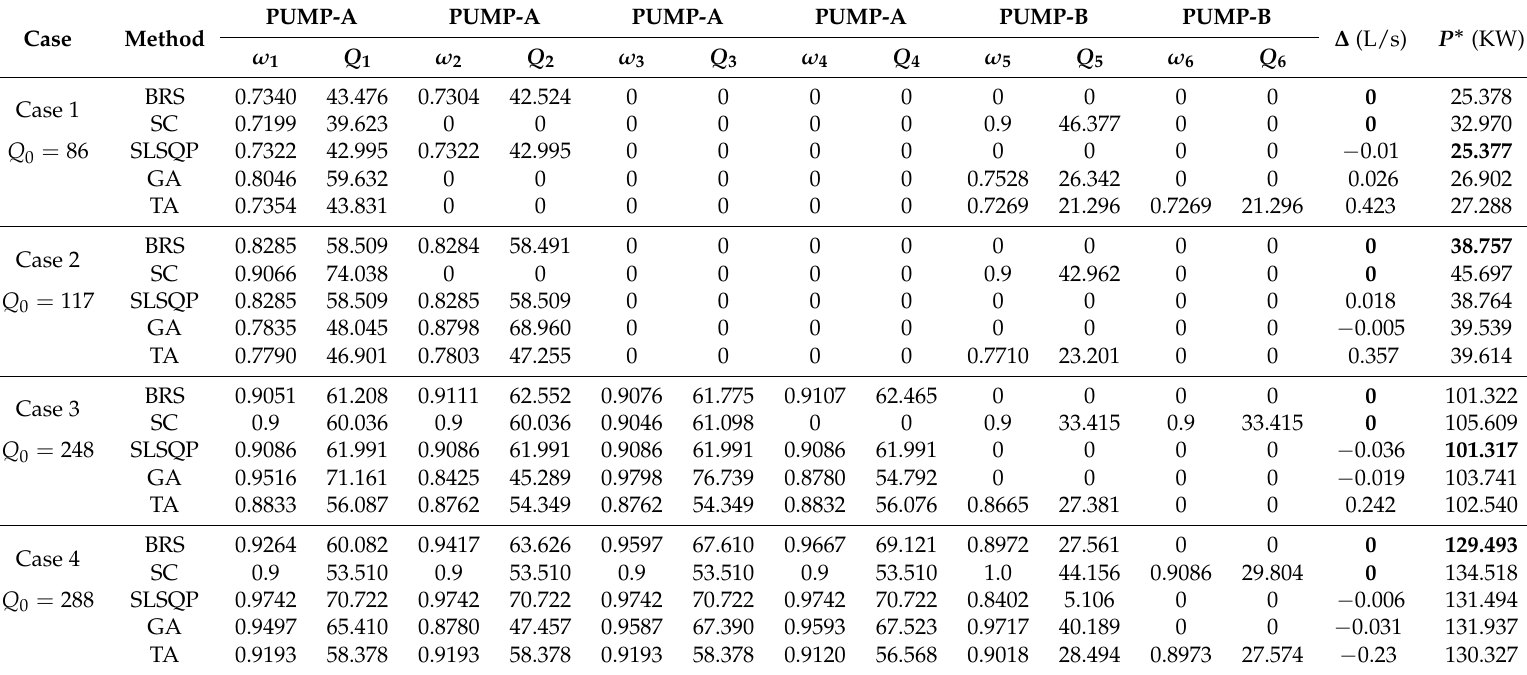
Table 5. Numerical comparison for different study